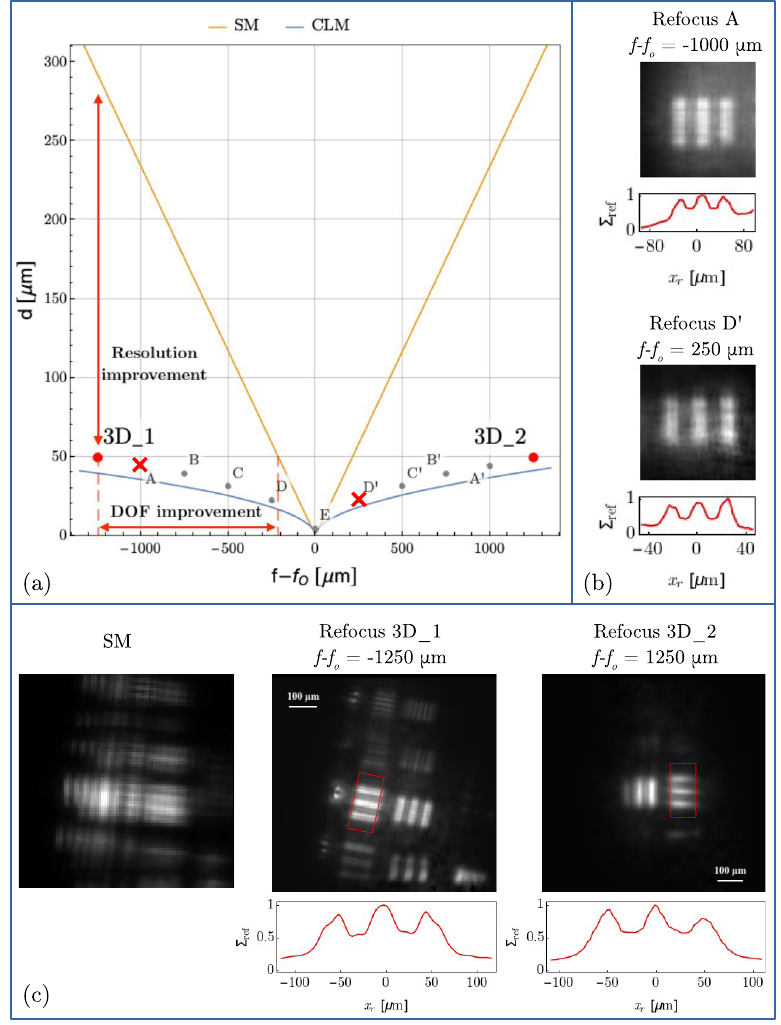
Figure 3. Panel ( a ) compares the resolution versus DOF compromise in a standard microscope (SM) and in CLM, with a numerical aperture NA 0 = 0.23 and illumination wavelength (cid:31) = 532 nm . The curves represent the limit at which a double-slit mask with center-to-center distance d (reported on the vertical axis and equal to twice the slit width) can be discriminated with a visibility of 10%, as a function of the longitudinal distance of the mask from the objective focal plane ( f − f O ). The curves are obtained assuming the same illumination wavelength and numerical aperture for the two microscopes. Points 3 D 1 and 3 D 2 indicate the parameters of a three-dimensional sample made of two planar resolution targets (triple slits with slit distance d = 49.6 µ m ) placed at a distance f 1 − f O = − 1250 µ m and f 2 − f O = 1250 µ m , respectively, from the objective. Points A to E, and A’ to D’ correspond to further experimental data demonstrating the expected maximum achievable DOF of CLM at different resolutions, as the object (a resolution test target) is moved away from the plane at focus (A, A’: d = 44.2 µ m at f − f O = ± 1000 µ m ; B, B’: d = 39.4 µ m at f − f O = ± 750 µ m ; C, C’: d = 31.3 µ m at f − f O = ± 500 µ m ; D, D’: d = 22.1 µ m at f − f O = ± 250 µ m , E: d = 4 µ m at f − f O = 0 µ m ). The refocused images of the triple slits corresponding to points A and D’ are shown in panel ( b ), while the other cases are reported in the Supplementary Information. The line plots below the refocused images show the image intensities, averaged along the vertical directions and normalized to their maxima. Panel ( c ) reports the images of the three-dimensional test sample described above, corresponding to points 3 D 1 and 3 D 2 in panel ( a ): image acquired by the standard microscope (left), CLM refocusing on the plane of the closest and farthest target, 3D 1 (center) and 3D 2 (right), respectively. The line plots below the refocused images show the intensities within the regions boxed in red, averaged along the longitudinal slit direction and normalized to their